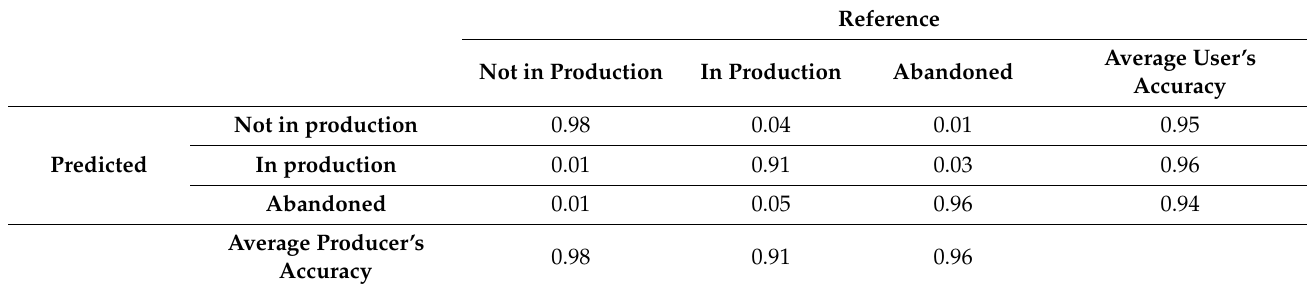
Figure 5. Example of reducing salt and pepper noise by adding Gray Level Co-Occurrence Matrix (GLCM) textural features. The noise decreases as the window size increases and this causes an increase in the accuracy of the pixel-based classification. ( a ) true color image, ( b ) spectral model classification, ( c ) 3 × 3 GLCM model classification, ( d ) 5 × 5 GLCM model classification, ( e ) 9 × 9 GLCM model classification, ( f ) plot-based classification. Table 4. Average confusion matrix obtained through 8-folds